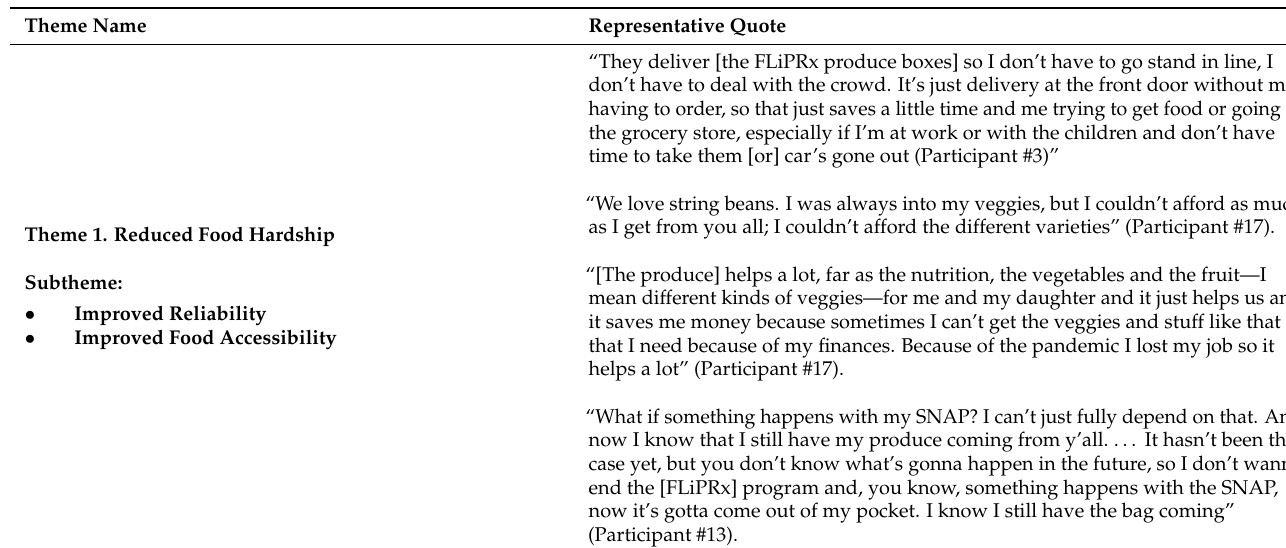
Table 2. Qualitative